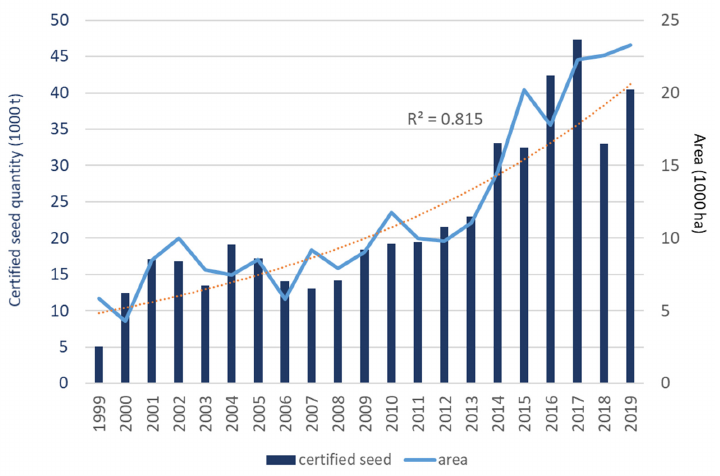
Figure 12. Area of field bean seed production and amount of certified seed between 1999–2019 in the EU member states [65].